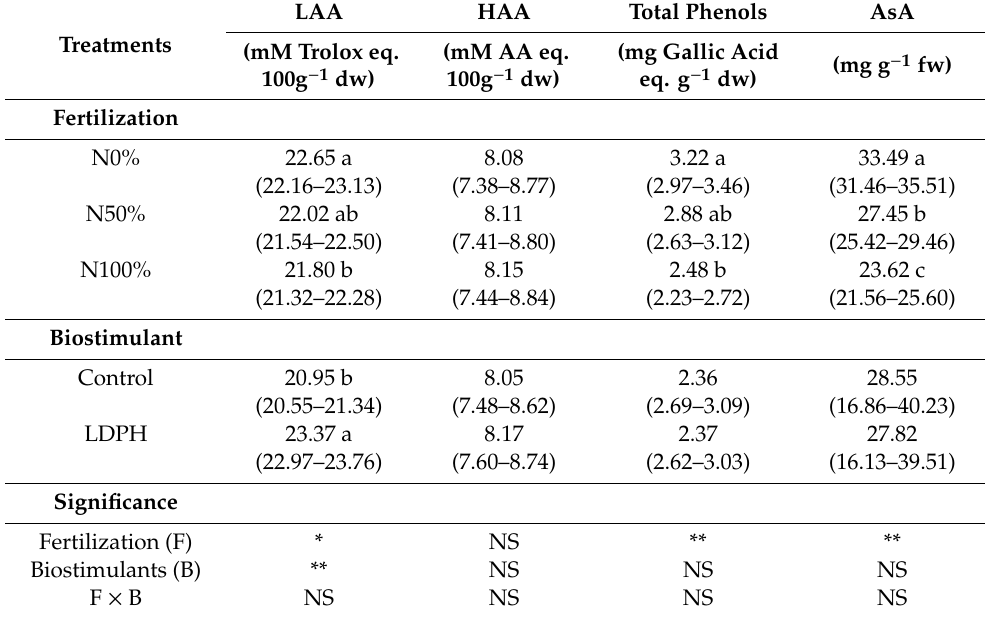
Table 5. Lipophilic (LAA) and hydrophilic (HAA) antioxidant activity, total phenols and ascorbic acid (AsA) of baby spinach plants as a ff ected by nitrogen (N) fertilization levels (0, 2.25 and 4.5 g N m − 2 ; N0%, N50%, N100%, respectively) and biostimulant applications (untreated control and LDPH: Legume-derived protein hydrolysates).